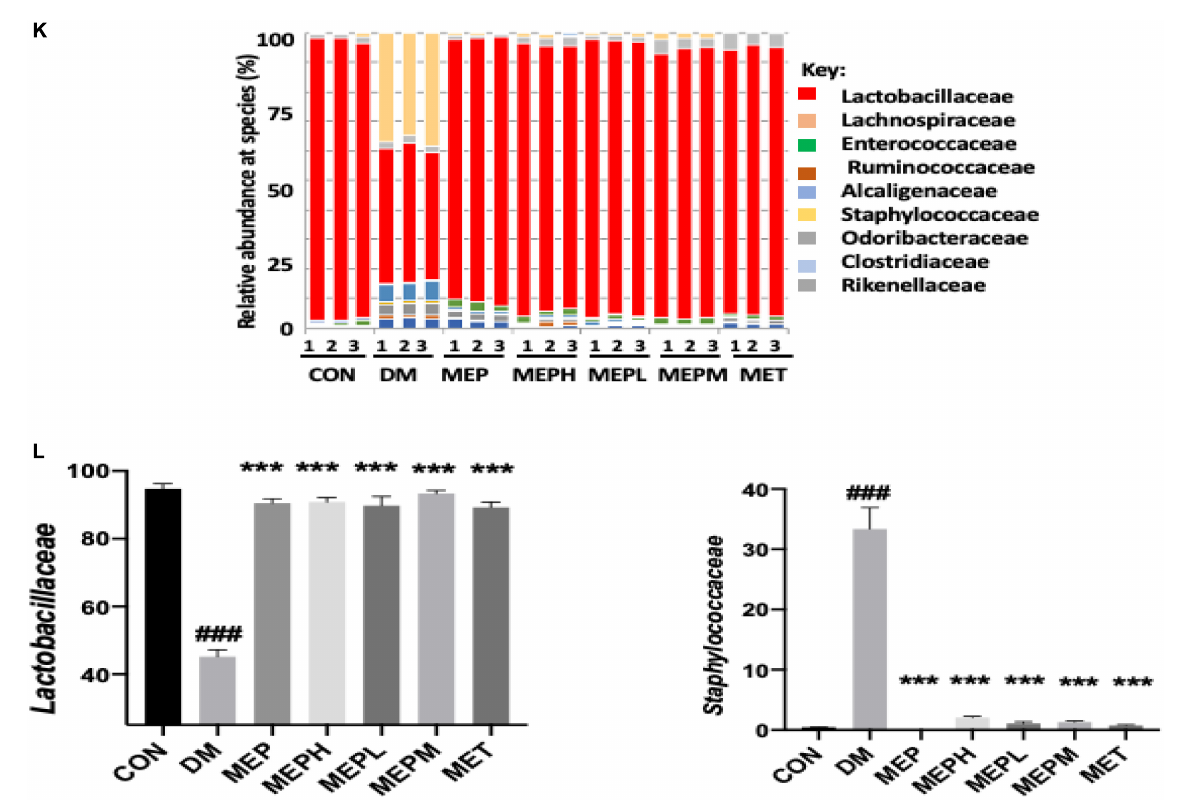
FIGURE5 Different taxonomic levels of microbial composition in T2DM mice. (A) Relative abundance at the phylum level, (B) Abundant flora at the phylum level (%), (C) Relative abundance at the genus level, (D) Abundant flora at the genus level (%), (E) Relative abundance at the family level, (F) Abundant flora at the family level (%), (G) Relative abundance at the order level, (H) Abundant flora at the order level (%), (I) Relative abundance at the class level, (J) Abundant flora at the class level (%), (K) Relative abundance at the species level, and (L) Abundant flora at the species level (%). # indicates a significant difference compared with control (CON) group. # p < 0.05, and ### p < 0.001 vs. Control. * indicates a significant difference compared with the DM group. * p < 0.05, ** p < 0.01, and *** p < 0.001 vs.